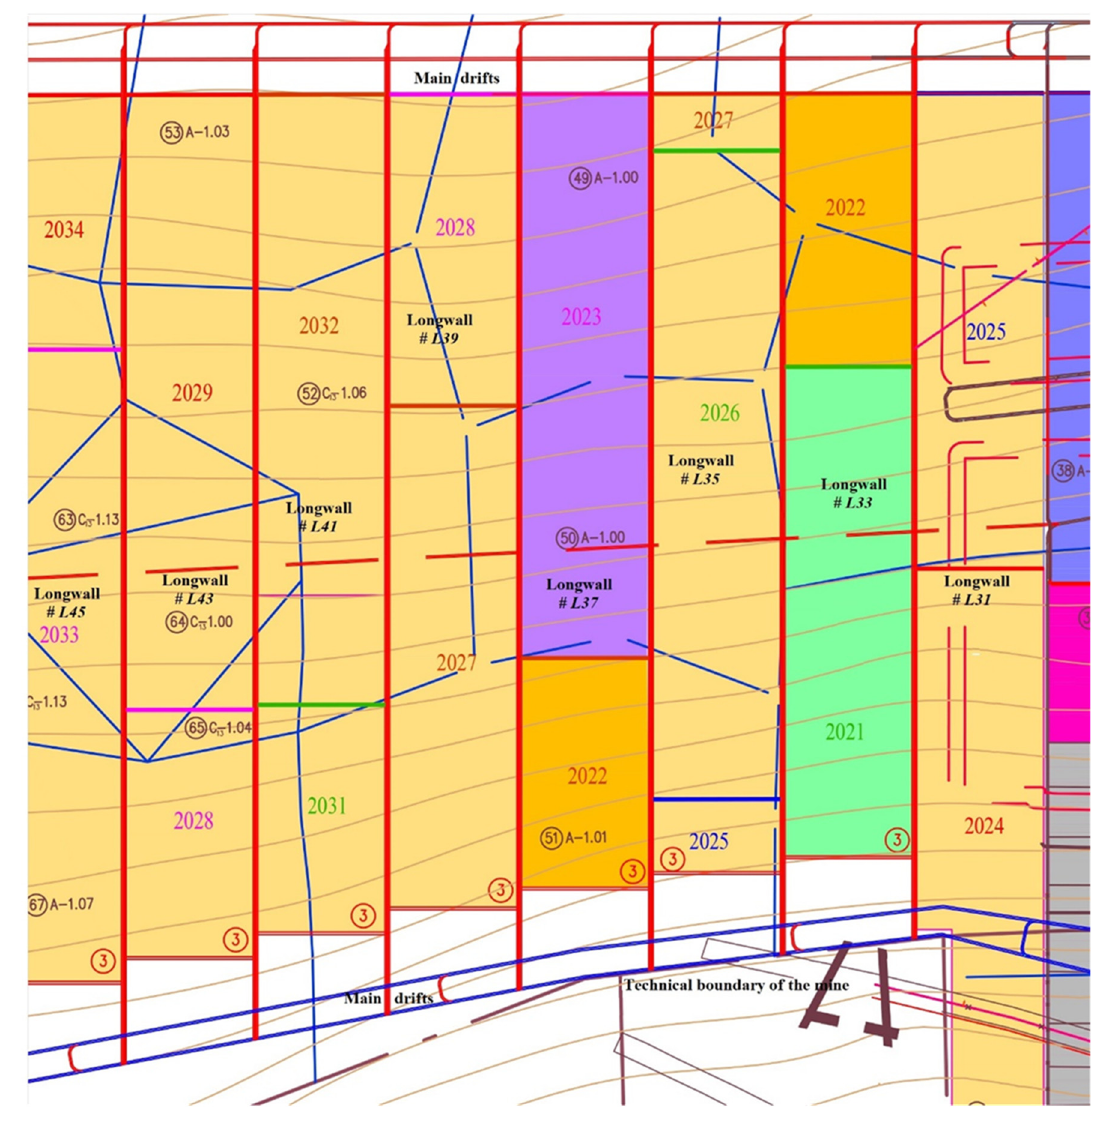
Figure 2. Plan of the mine field: —exploration well number with the indicated coal seam thickness; 2025—planned year of pillar exploration.